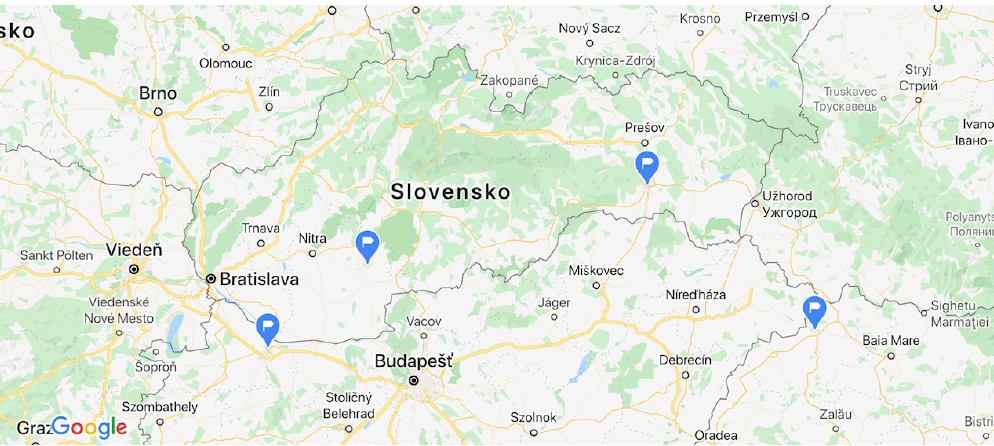
Figure 4. Locations of four Roma vajdas (dukes): Györ, Košice, Levice, Satu Mare (blue pointers). Source: Google Maps, 2020 and the authors.